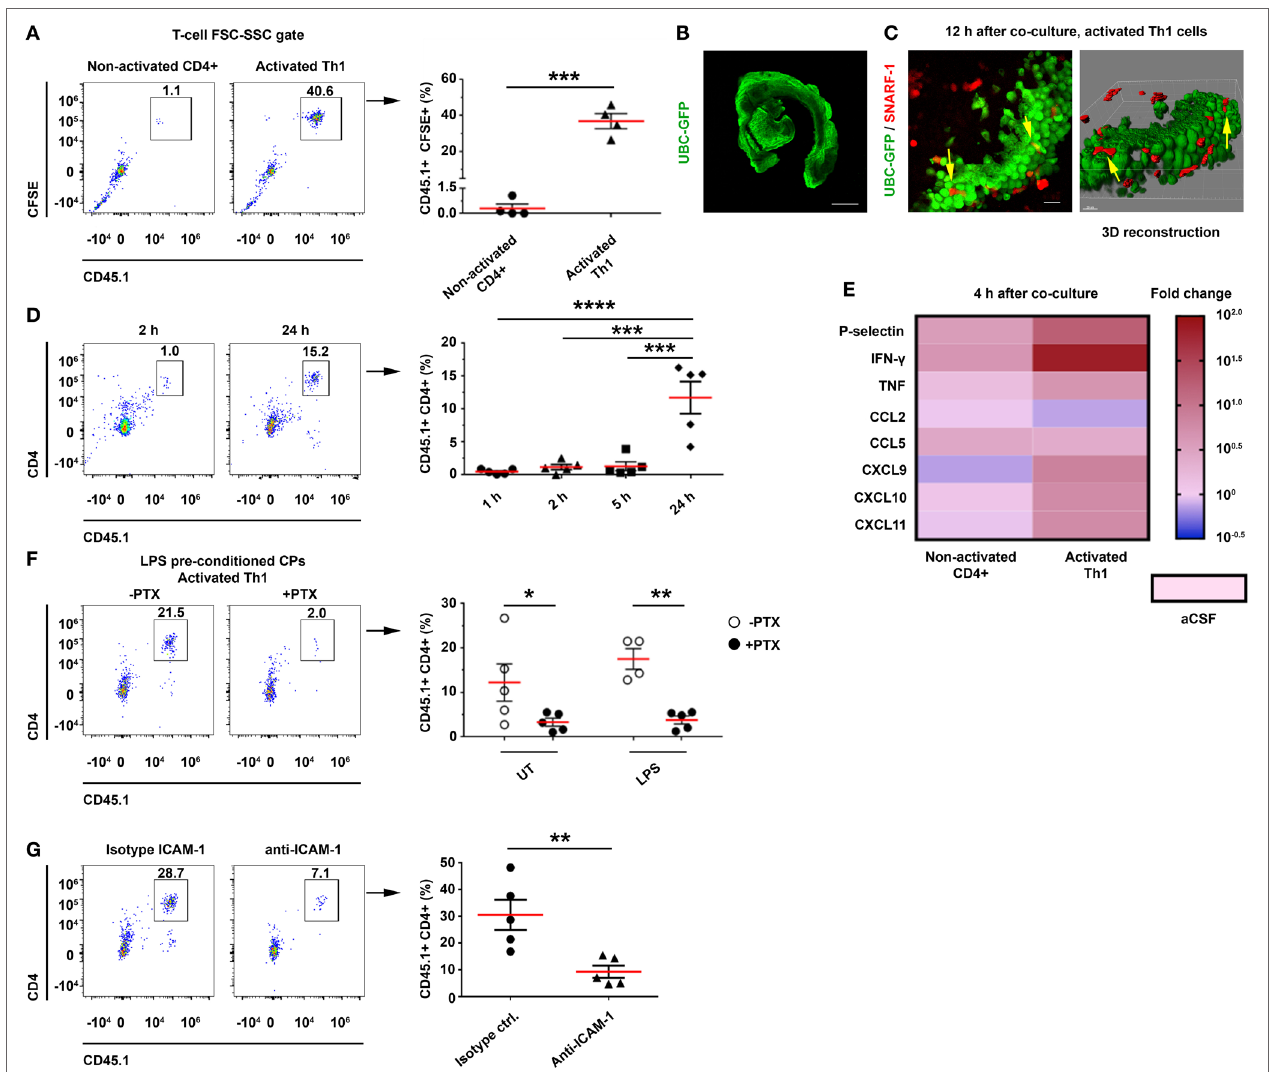
FigUre 5 | CD4 T cells home to the choroid plexus (CP) in an activation-, chemokine-, and intercellular adhesion molecule 1 (ICAM-1)-dependant manner. Intact lateral ventricle (LV) CPs from non-perfused CD45.2 mice, with or without lipopolysaccharide (LPS) preconditioning, were cocultured ex vivo with CD45.1 CD4 T cells in artificial CSF (aCSF) and then analyzed with flow cytometry and confocal microscopy. (a–e) Ex vivo cocultures, showing the homing of activated T cells to the CP with flow cytometry and live-cell imaging, and their impact on gene expression. (a) Flow cytometry analysis of the FSC-SSC T-cell population in untreated (UT) CPs cocultured for 24 h with CD45.1 + carboxyfluorescein succinimidyl ester-labeled non-activated (Non-activated CD4 + ; n = 4) or activated (Activated Th1; n = 4) T cells. (B,c) Confocal live-cell imaging of UT, GFP-labeled CPs, which were derived from UBC-GFP mice (B) and cocultured with SNARF-1 + Th1 cells adhering to and migrating within the CP [ (c) ; yellow arrows indicate interactions]. Scale bars represent 500 µm (B) , 20 µm (c) . (D) Homing kinetics of